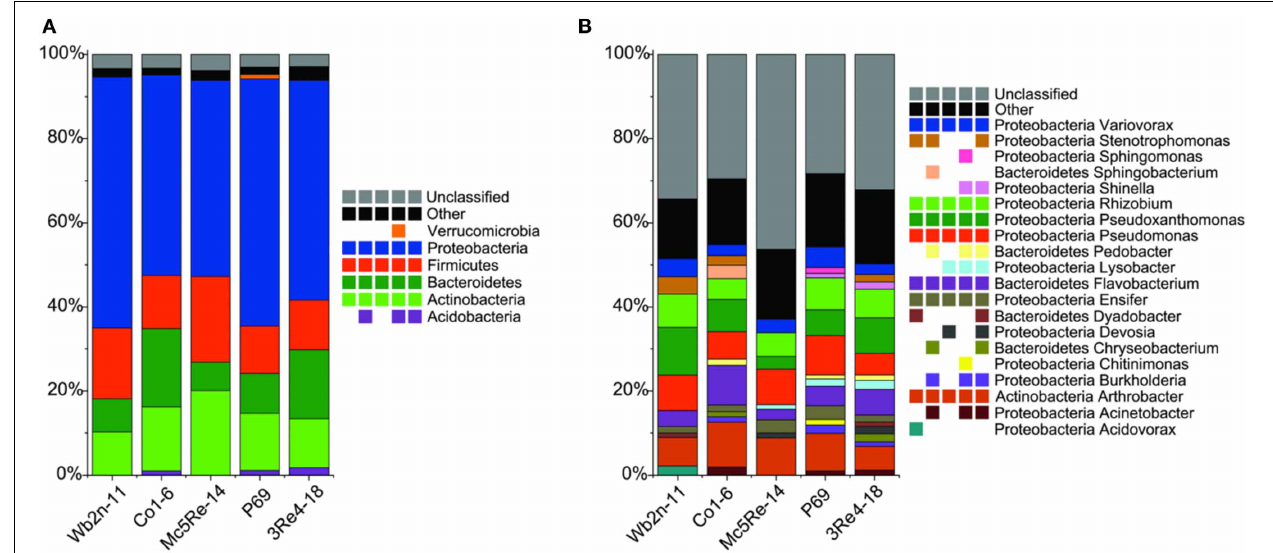
FIGURE 4 | Classification of bacterial communities associated with Chamomilla recutita (L.) Rauschert. Pyrosequencing reads were classified at phylum (A) and genus (B) level against RDP core set within QIIME pipeline